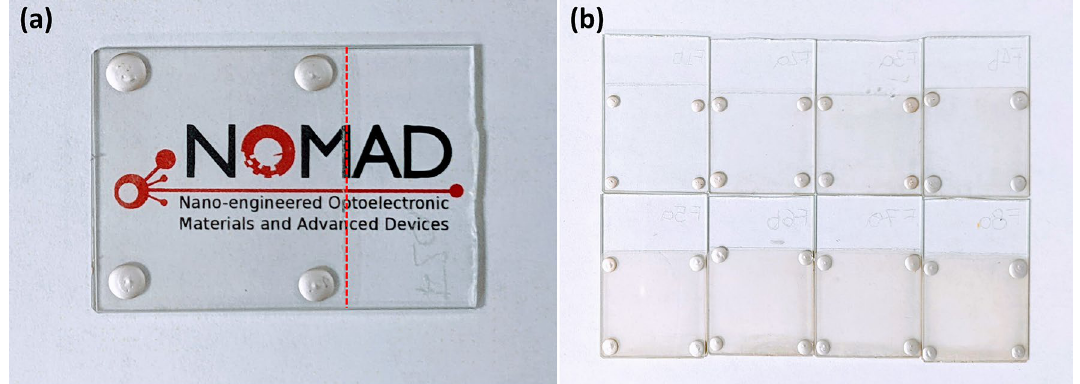
Figure 2. TCE electrodes on glass after photonic annealing. ( a ) Two-layer sample on a piece of paper to highlight its good transparency. The red dashed line shows where the film ends ( b ) Samples showing an increasing number of silver nanowire layers and how their transparency is progressively reduced.